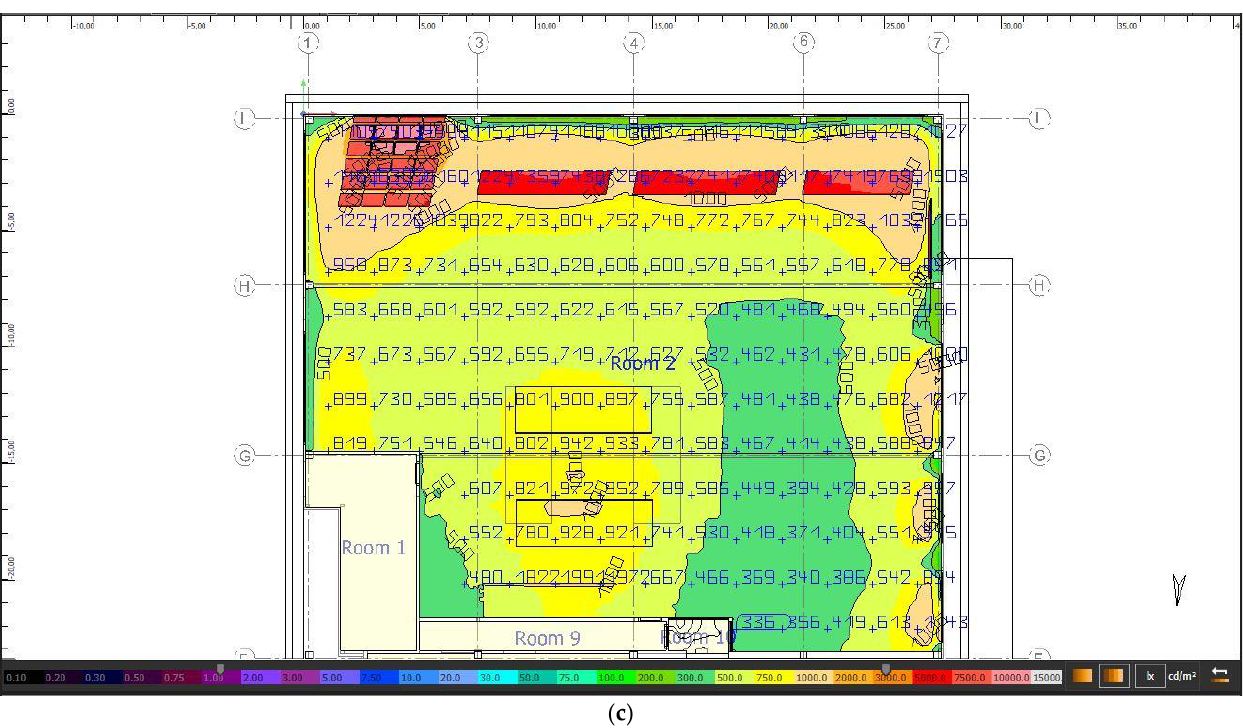
Figure 5. Design, calculation and visualisation of natural light in the service workshop: the layout of longitudinal skylights on the floorplan of the studied object ( a ); the model of the interior of the building with selected skylights ( b ); the Luxplot resulting from two longitudinal skylights of 2000 × 5880 mm dimensions at 1:00 p.m. on 22 September 2020 ( c ).